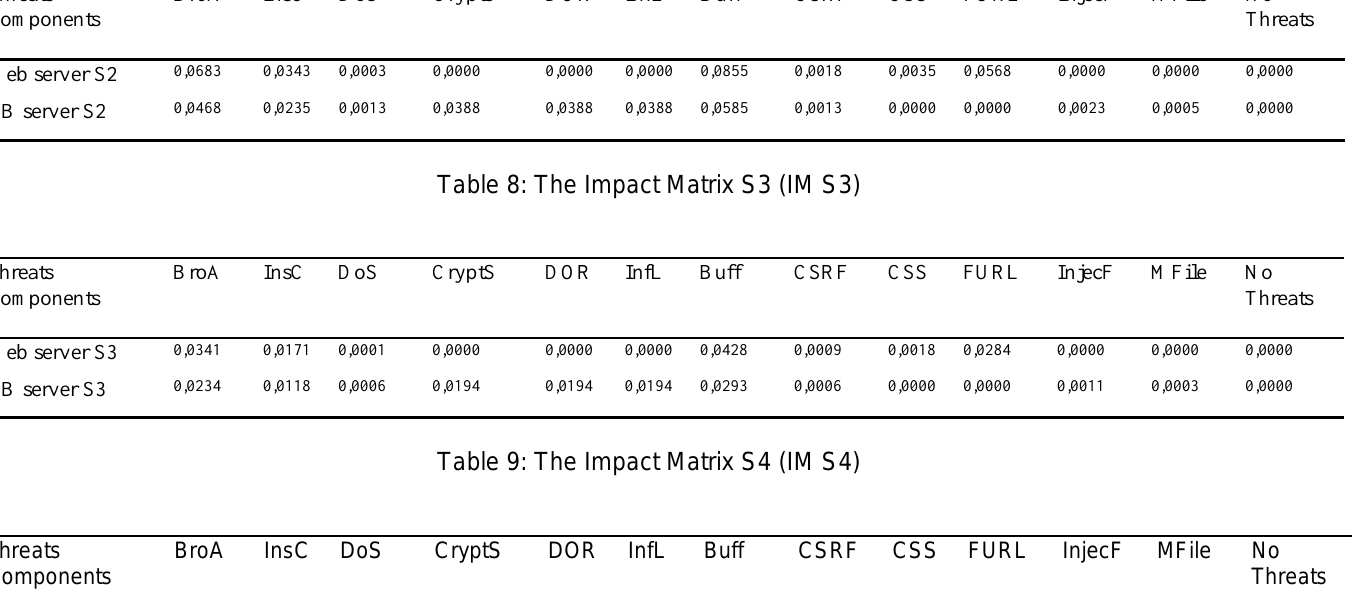
Table 7: The Impact Matrix S2 (IM S2)